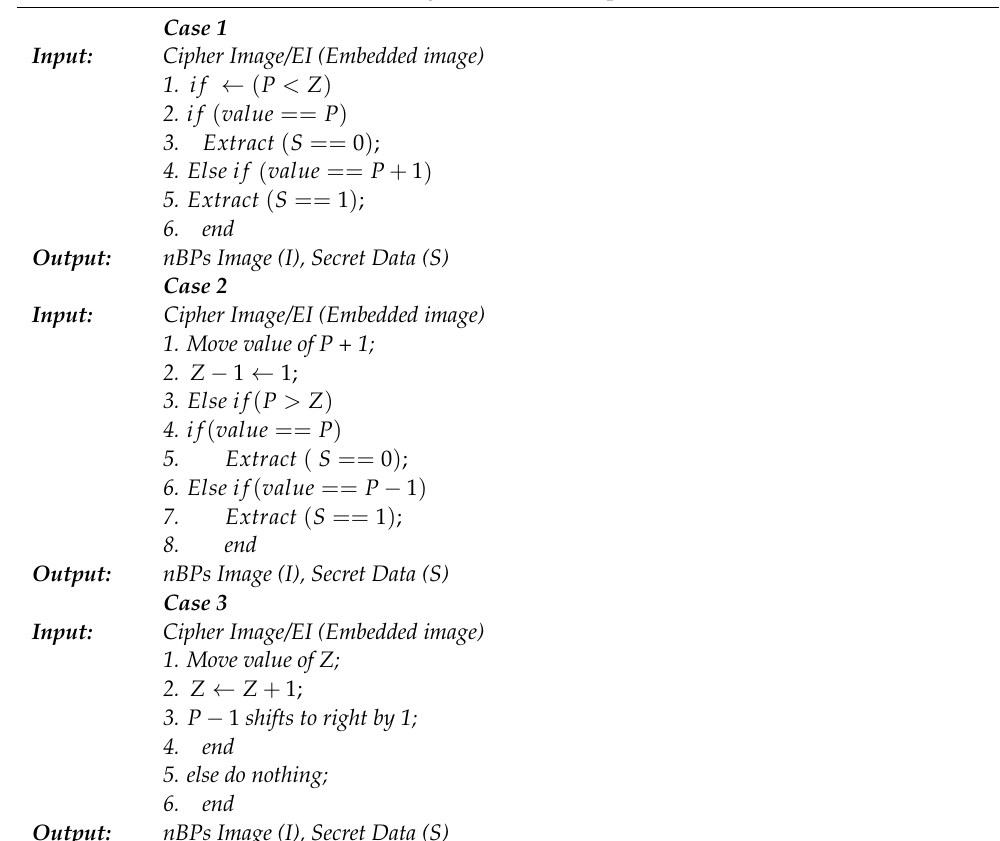
Algorithm 2: Pseudocode Extraction Algorithm of the Proposed